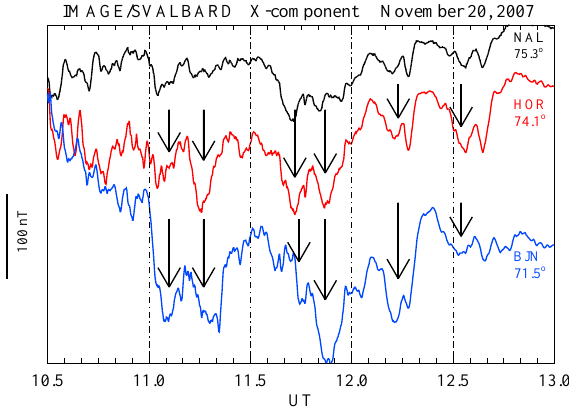
DPY magnetic deflections (SM effect): Pulsed antisunward convection at post-noon MLTs Fig. 18. IMAGE Svalbard X-component deflections at stations NAL (75 ◦ MLAT), HOR (74 ◦ MLAT), and BJN (71 ◦ MLAT) for the interval 10:00–13:00UT, 20 November 2007. Major deflection events (negative deflection maxima) are marked by arrows in the HOR and BJN panels at 11:05, 11:18, 11:42, 11:52, and 12:12UT.